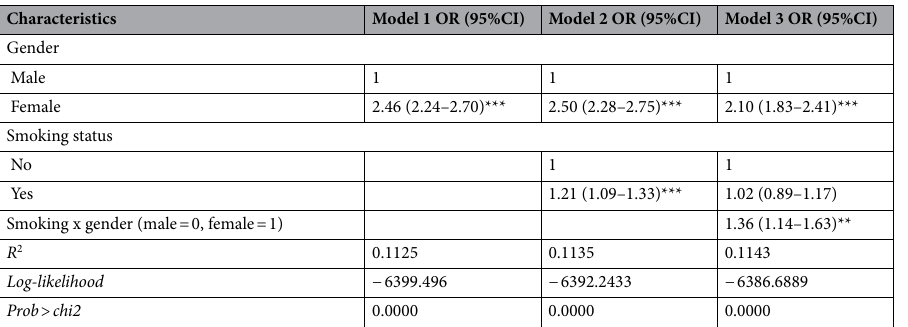
Table 4. Hierarchical regression models assessing the interaction between gender and cigarette smoking on suicidal attempts. Model 1 tested the independent effect of gender on suicidal attempts; Model 2 tested the independent effects of gender and smoking on suicidal attempts; Model 3 tested the interaction between gender and smoking on suicidal attempts. All model adjusted for age, alcohol intake, drug use, physical activity, lack of sleep, parental involvement, physical violence, bullying, loneliness, truancy. *** p < 0.001; ** p < 0.01; * p <